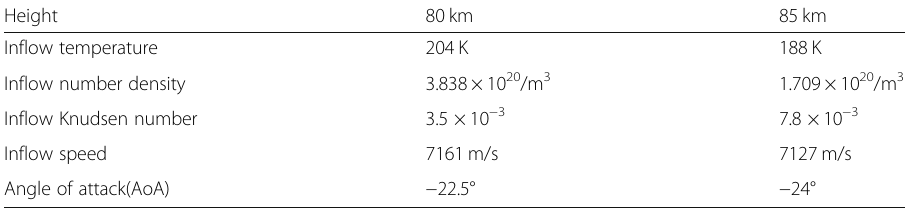
Table 8 Typical related parameters of the lunar exploration type capsule for the second reentry